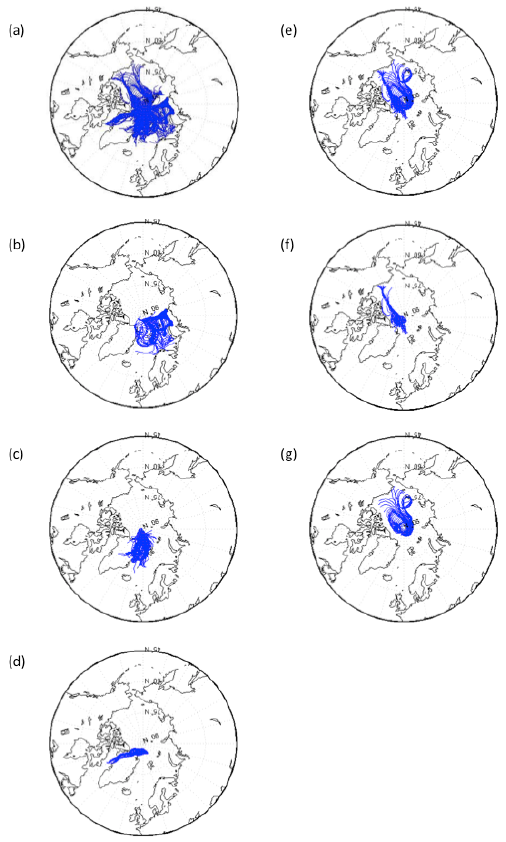
Fig. 2. Backward trajectory clusters with an arrival height of 100m at the position of the icebreaker during (a) the ice drift (PI-drift), (b) cluster 1 (DOY 227, DOY 229–232) originated easterly from Figure 2. Air mass trajectory clusters with an arrival height of 100 m at the position of the 3 the Barents and Kara seas, (c) cluster 2 (DOY 228, DOY 236, 238– icebreaker during: (a) the ice drift (PI-drift), (b) cluster 1 (DOY 227, DOY 229-232) originated 4 239) from the Greenland Sea–Fram Strait area, (d) cluster 3 (DOY 234–235) from Greenland, (e) cluster 4 (DOY 240–246) from the easterly from the Barents - and Kara Seas, (c) cluster 2 (DOY 228, DOY 236, 238-239) from the 5 northwestern circumpolar region over the pack ice, (f) sub-cluster Greenland Sea- Fram Strait area, (d) cluster 3 (DOY 234-235) from Greenland, (e) cluster 4 6 4a (DOY 240–243), and (g) sub-cluster 4b (DOY 243–246). (DOY 240-246) from northwestern circumpolar over the pack ice, (f) sub-cluster 4a (DOY 240- 7 243), and (g) sub-cluster 4b (DOY 243-246). 8 5 Atmospheric particulate mass concentrations of hydrolyzed